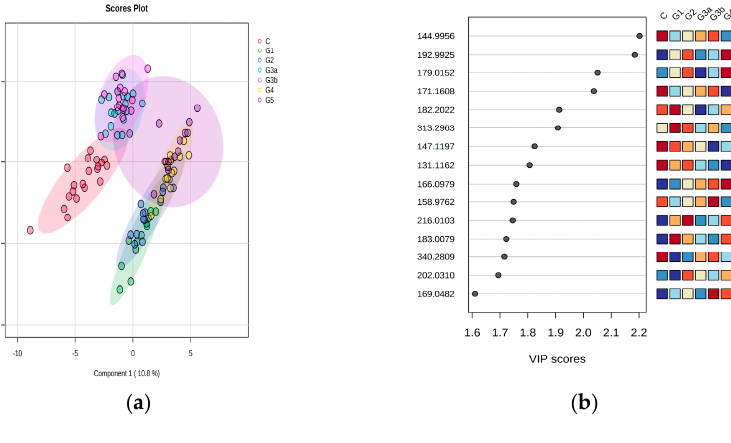
Figure 2. ( a ) PLSDA score plot representing the discrimination between group C and subgroups G1–G5 in blood serum. ( b ) VIP score plot for the top 15 molecules, with VIPs > 1.6. ( c ) MDA values for the top 15 molecules to be considered as potential biomarkers of progression from G1 to G5. In agreement with the VIP and MDA scores (Figure 2b,c), the most significant molecules to be considered predictive for the discrimination between group C and subgroups G1–G5 and with progressive decrease in levels from group C to the groups with lower eGFRs, namely, subgroups (G1 to G5), were Oleoyl glycine (340.2809), N-Butyrylglycine (m/z = 144.9693), Propylthiouracil (m/z = 171.1608), Glutamine (m/z = 147.1197), and Ketoleucine (m/z = 131.1162). The opposite ranking shows molecules with increased levels in subgroups G1 to G5 as compared to group C, e.g., 5-Hydroxyindoleacetic acid (m/z = 192.9925), Phenylalanine (m/z = 166.0979) Pyridoxamine (m/z = 169.1529), Cysteinylglycine (m/z = 179.0152), Propenoylcarnitine (m/z = 216.0103), and Uridine (m/z = 245.0952).